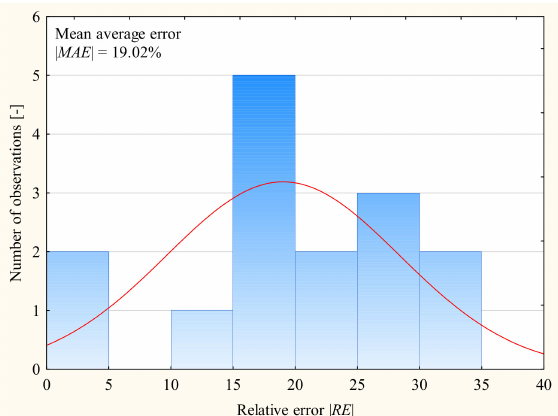
Figure 7. Relative error histogram | RE | of U m mass humidity obtained using the gravimetric method, as well as U mc humidity identified by means of an artificial neural network for experimental verification (red curve shows the perfect fit for the normal distribution of the relative